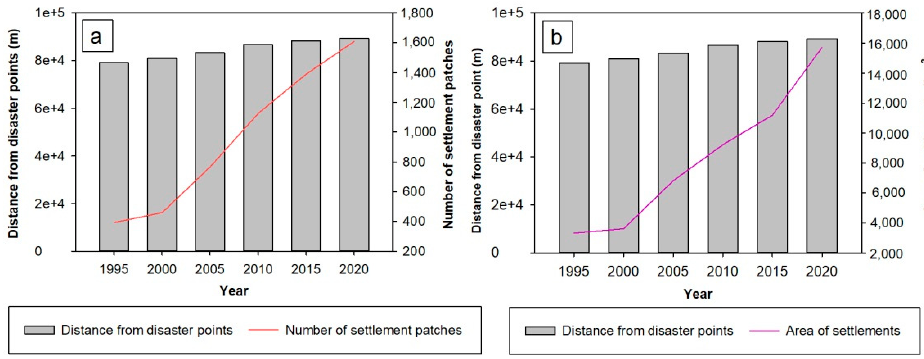
Figure 14. Relationship between hazard points and settlements. a) Distance from hazard points and number of settlement patches; b) distance from hazard points and area of settlements.